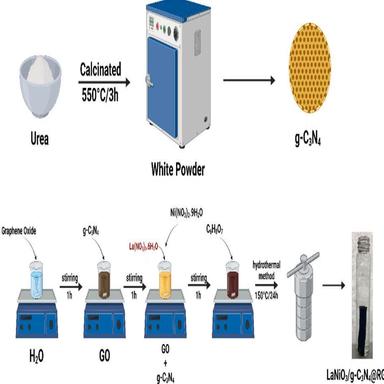
Diagram showing the steps involved in creating the three-dimensional hybrid structure.